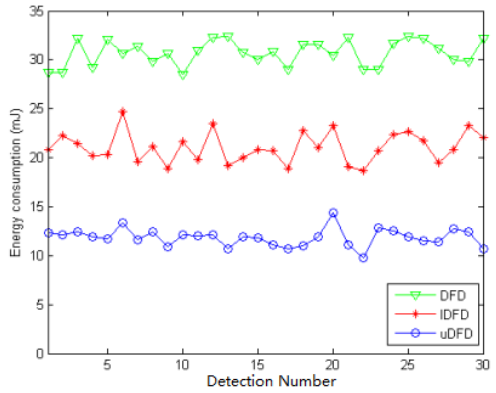
Figure 16. Energy consumption of each detection under 120 working node